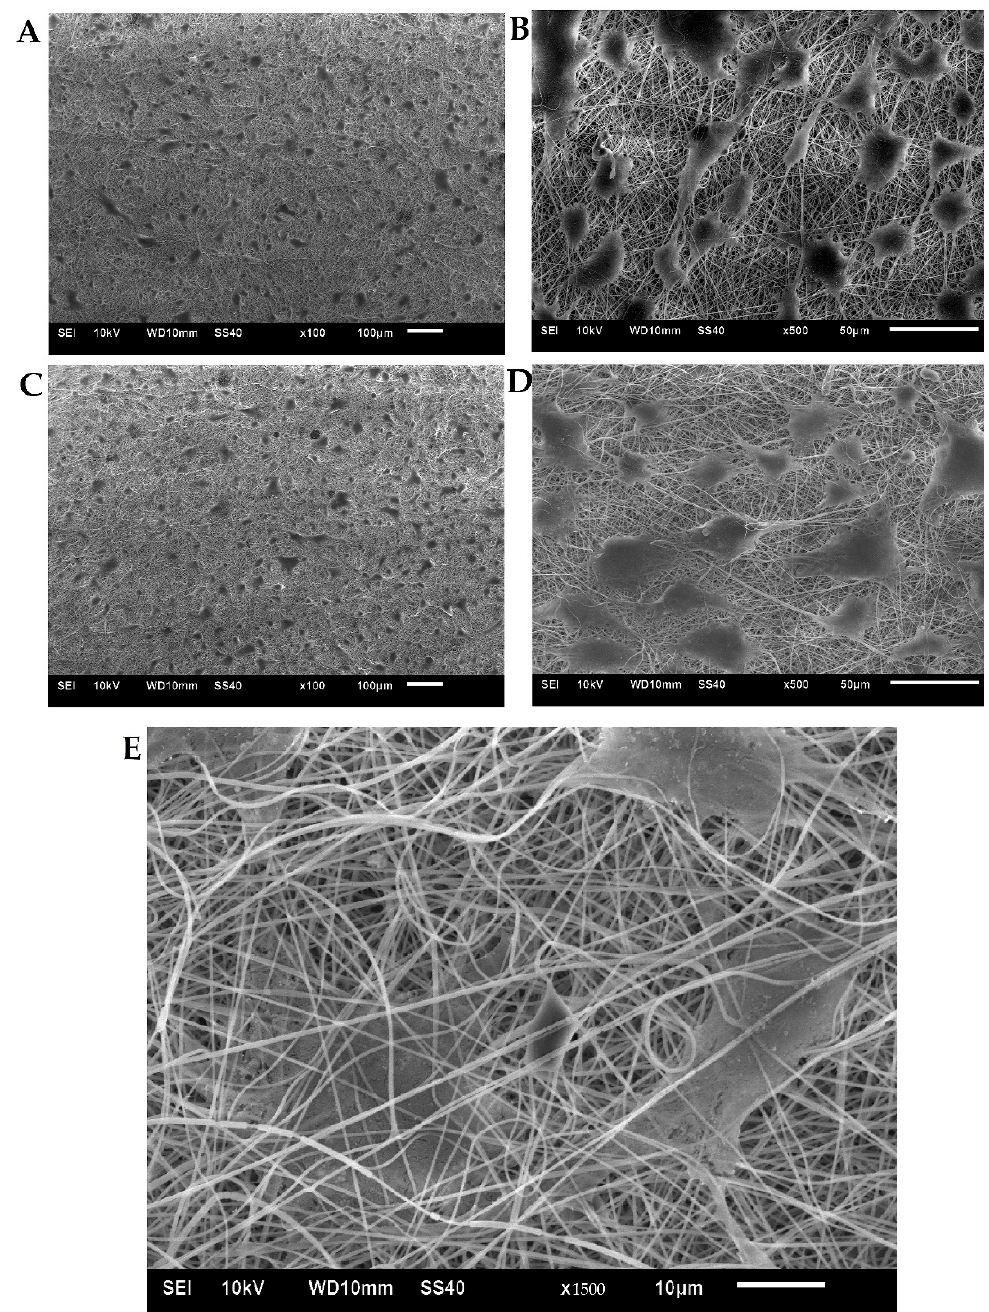
Figure 8. SEM images of primary porcine NP cell morphology on fibroin/gelatin electrospun mem- × ; ( B ) 24 h, 500 × ; ( C ) 72 h, 100 × ; ( D ) 72 h, 500 × ; ( E ) 72 h, 1500 × brane: ( A ) 24 h, 100×; ( B ) 24 h, 500×; ( C ) 72 h, 100×; ( D ) 72 h, 500×; ( E ) 72 h, 1500×. membrane: ( A ) 24 h, 100